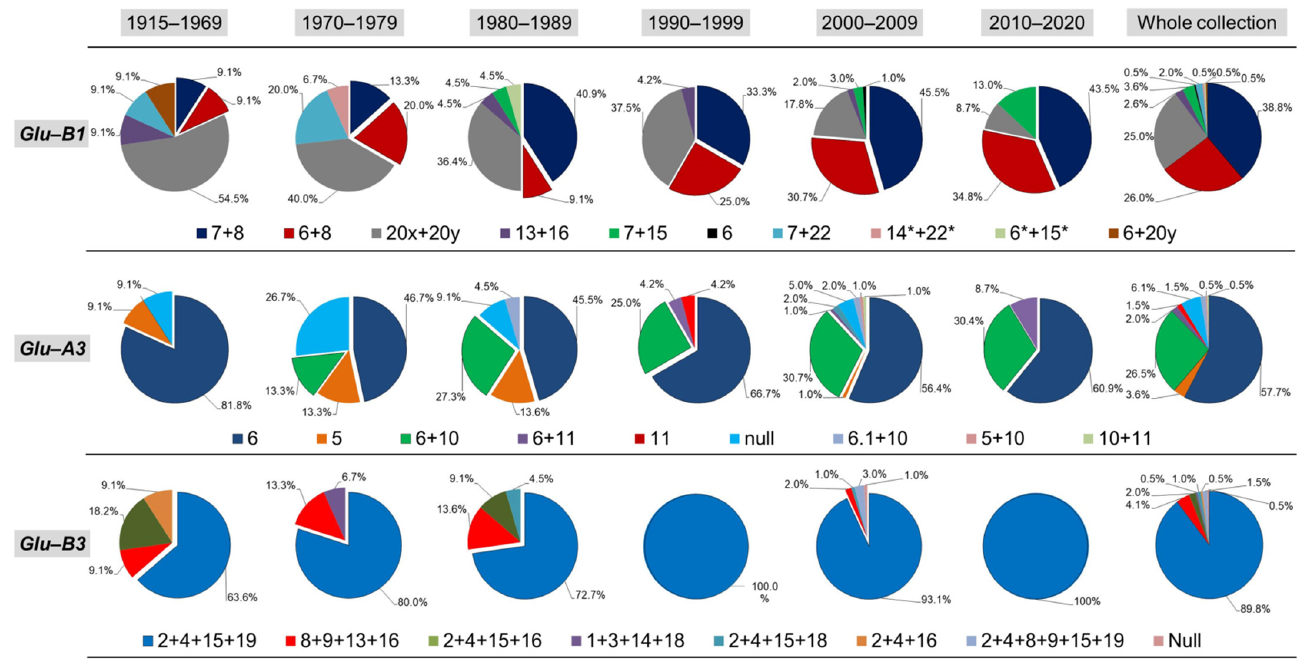
Figure 2. Allelic distribution of the three main glutenin loci ( Glu-B1 , Glu-A3 and Glu-B3 ) in a worldwide collection of durum wheat over six breeding periods.